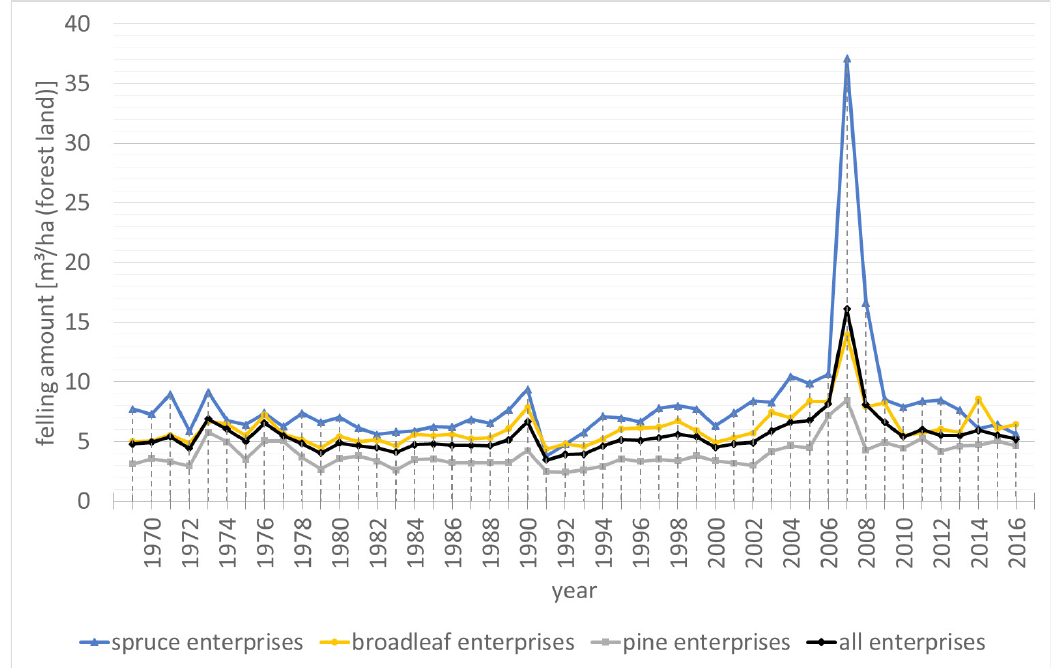
Figure 1: Felling amount per hectare forest land according to consultancy